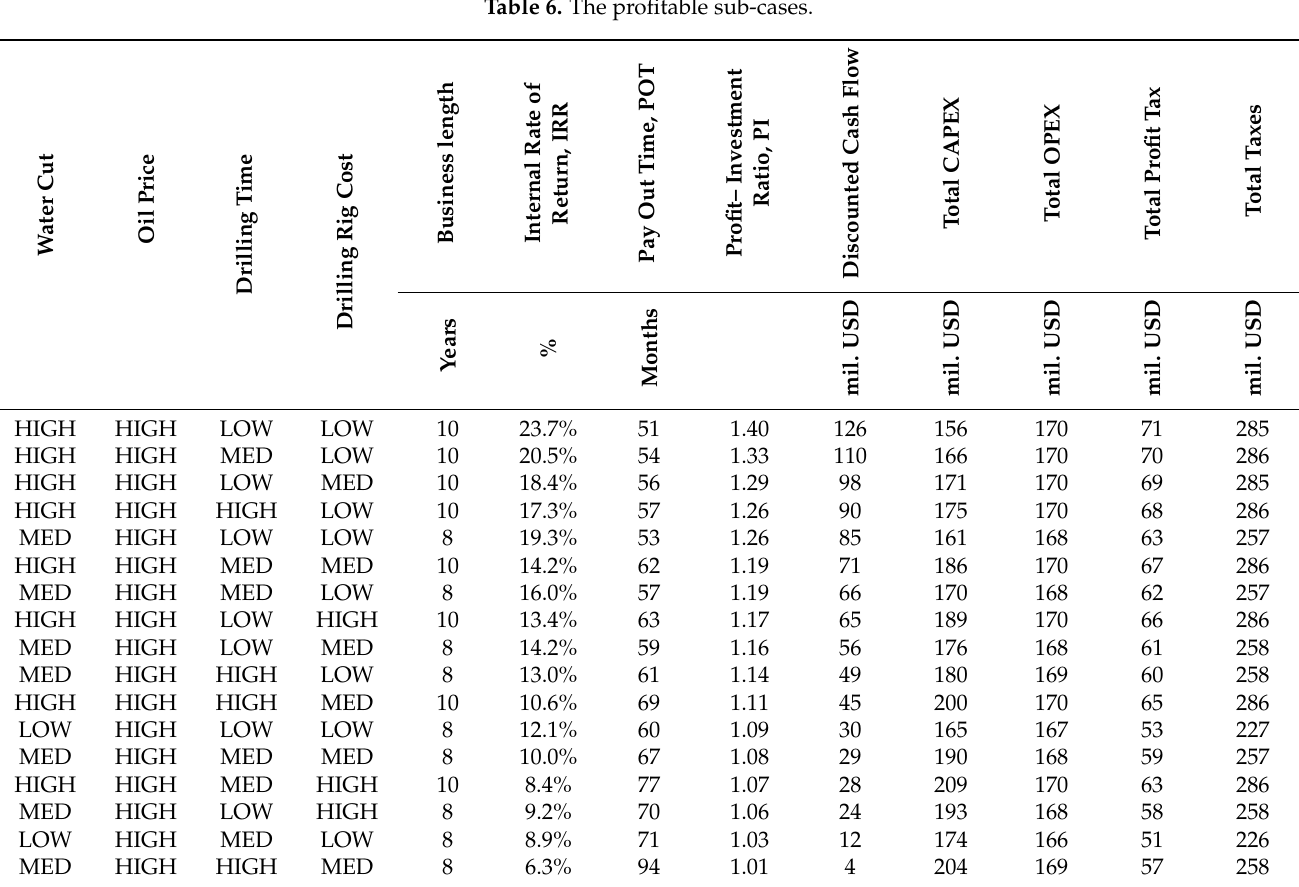
Table 6. The profitable